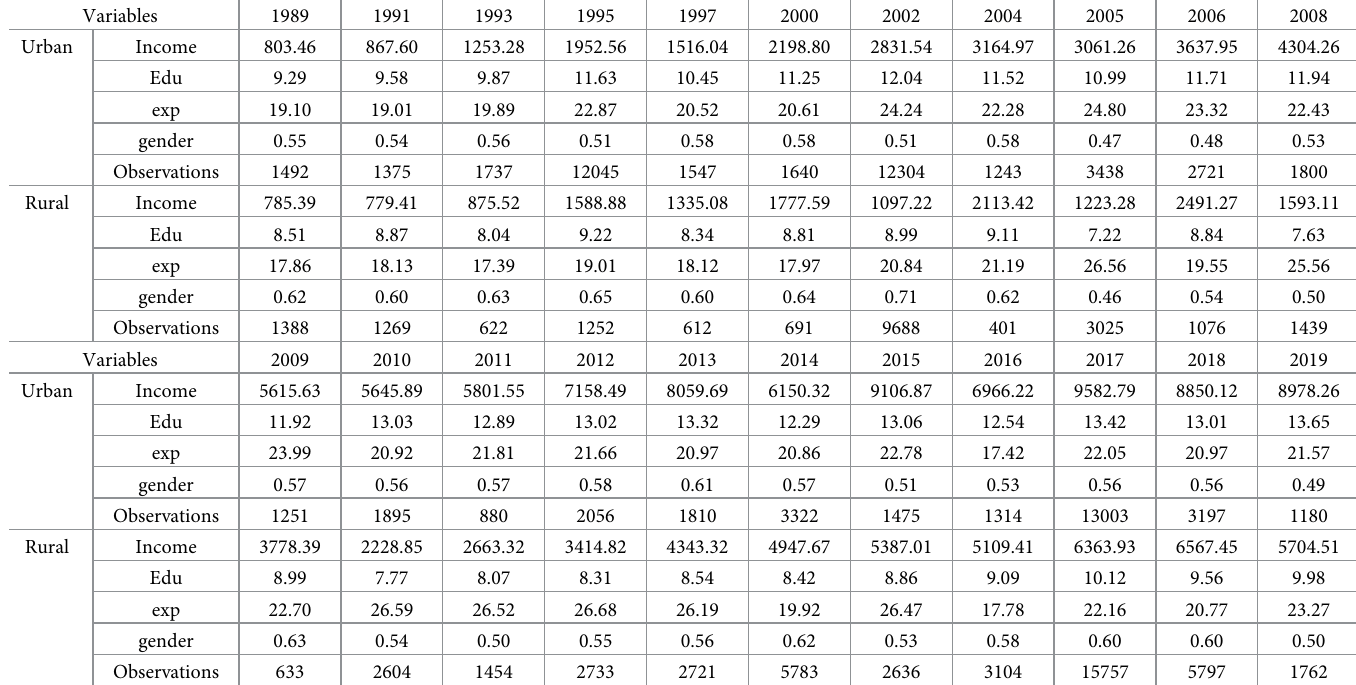
Table 1. Descriptive statistics: Mean.